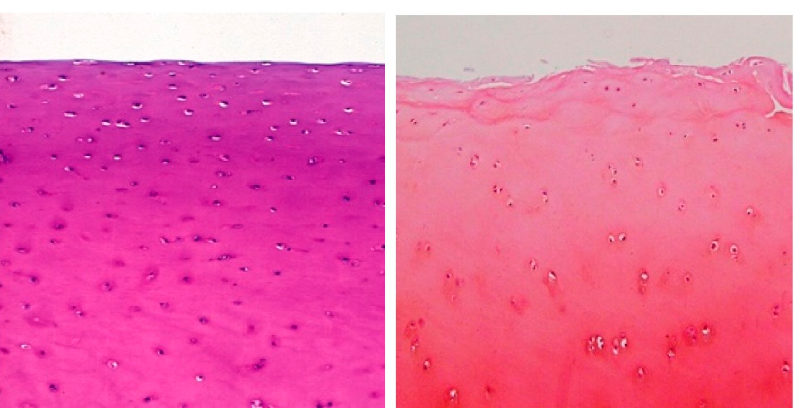
Figure 3. Normal (left panel) and early OA (right panel) human articular cartilage. Histological sections stained pink with safranin O (metachromatic dye). In normal tissue, chondrocytes are dispersed within the extensive extracellular matrix. Superficial cells, adjacent to the articular surface (top of image), are slightly flattened, reflecting the orientation of collagen fibers in this region. Early OA is associated with heterogeneity of proteoglycan staining (reduced near the articular surface with patchy increased staining deeper within the tissue). The articular surface loses its congruity and is associated with fibrillation and fissuring (20× magnification).